Question: In a single sentence, describe what this figure presents.
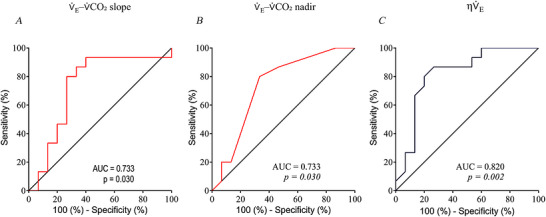
Answer: Proof‐of‐concept application of η V ˙ E in smokers without chronic obstructive pulmonary disease Receiver operating characteristic (ROC) curves for conventional indices – ( A ) V ˙ E – V ˙ C O 2 slope and ( B ) V ˙ E / V ˙ C O 2 nadir – compared with the novel η V ˙ E ( C ) in discriminating smokers with reduced diffusing capacity (DLco < LLN). η V ˙ E exhibited the highest diagnostic accuracy (AUC = 0.82; sensitivity 87%, specificity 73%), outperforming both conventional indices (AUC = 0.73 for slope and nadir). Adapted from Muller, P.T. et al. ( 2021 ), with permission.